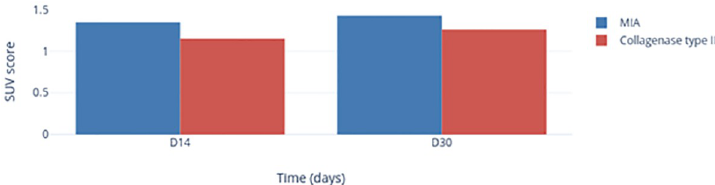
Fig 8. Change in the FDG level after MIA (blue) or Col-2 (red) injection as a function of time.